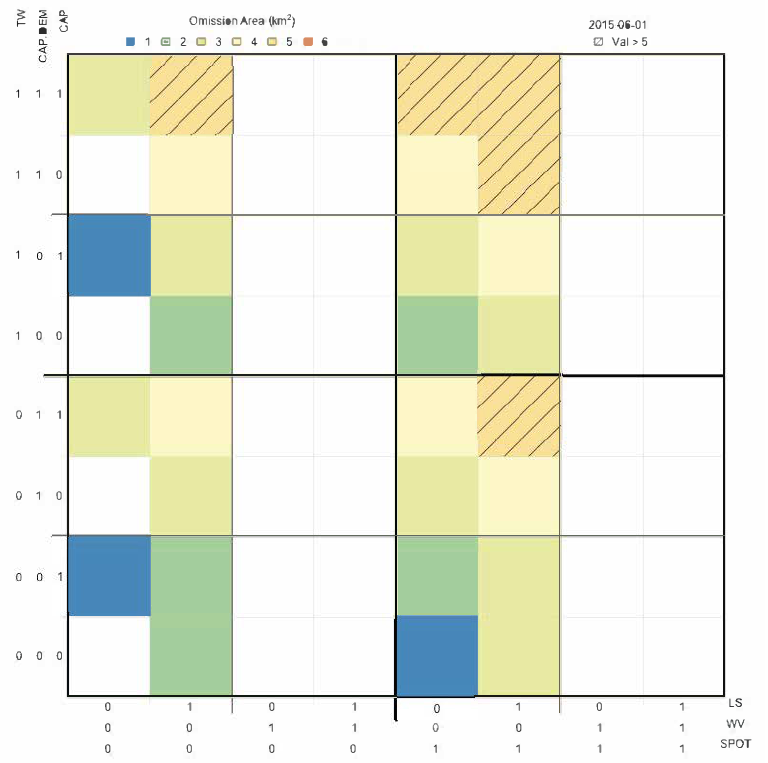
Figure 12. Areas of omissions for all data combinations available for 1 June 2015. Figure 12 represents the areas of omissions based on the data combinations from all data available for 1 June 2015, a day of the flood peak. Satellite observations are listed along the x-axis, and social media with aerial photos are along the y-axis. Dataset combinations that estimate an omission area larger than the threshold value are emphasized by a cross- line pattern. For this example, it can be inferred that both satellite data are not necessarily needed as long as any of the other datasets are available. Either SPOT or LS are suitable as long as they are fused with other data. Additionally, looking at SPOT and LS individually, it can be determined that SPOT has a smaller area of omission than that of LS for this single day. This concept can also be used to highlight which data are needed to estimate areas of omission greater than 5 km 2 . In this case, the options are a lot less limited and cannot rely only on a single dataset, but there must be access to specific data combinations such as the ones shown with a cross-lined pattern in Figure